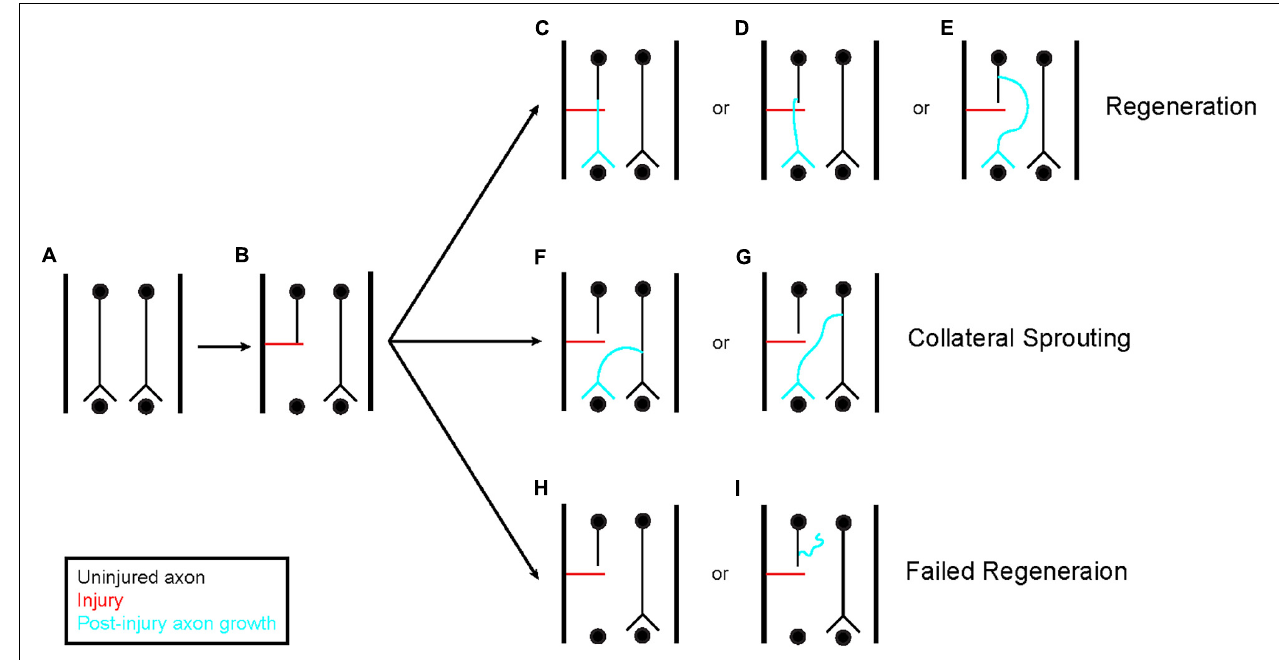
FIGURE 1 | Axon regeneration and collateral sprouting. A few different classes of response can occur following axon injury (A,B) . First, the injured axon can regenerate (C–E) . This regeneration can originate directly from the transected tip (C) or from the axon shaft (D,E) . Regeneration from the axon shaft can occur close to the injured end (D) or from a region more remote to the injury site (E) . The regenerating axon does not have to pass through the injured tissue, it can also navigate around the tissue as shown in (E) . In addition to regeneration, axons that were spared from injury can sprout collaterals to reinnervate the denervated tissue and compensate for the damage (F,G) . This is a distinct process from regeneration. These collaterals can originate anywhere on the intact axon. Finally, the axon can fail to regenerate (H,I) . This can be observed through a complete failure to generate new growth (H) or new growth that fails to navigate distal to the site of injury (I) . These three classes of response are not mutually exclusive, each one can occur simultaneously at the same injury site across the population of injured axons.